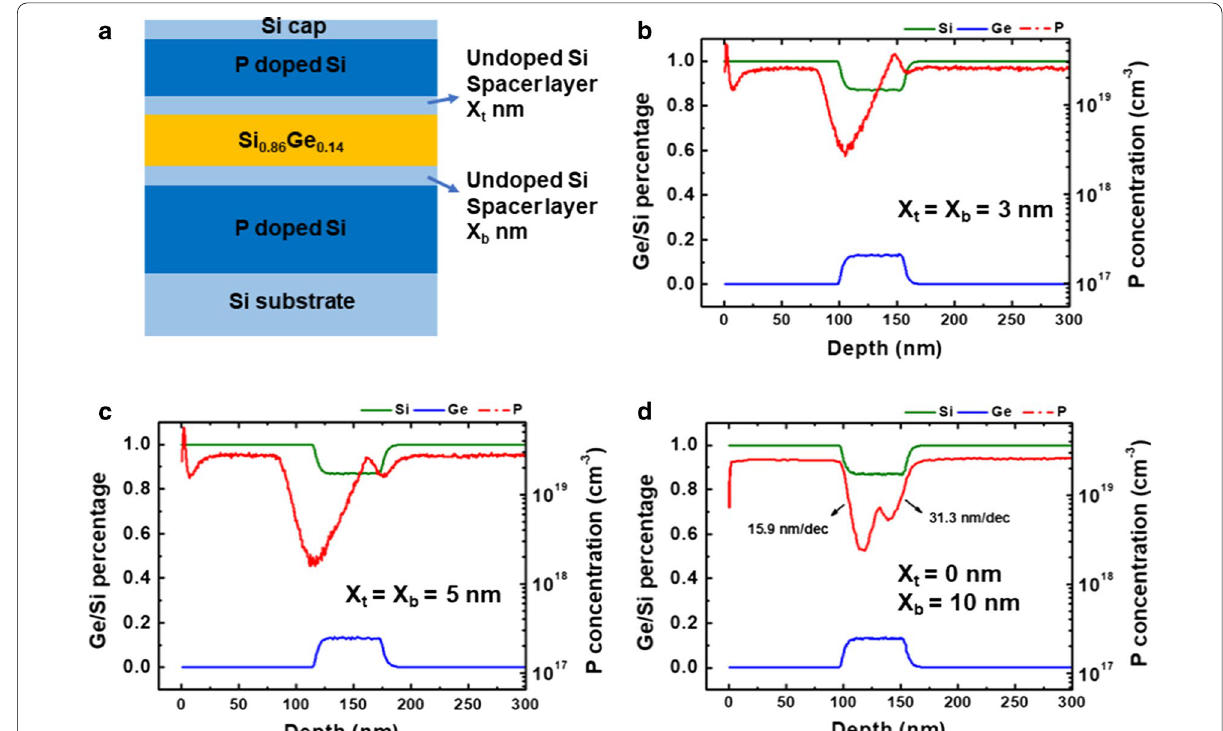
Fig. 2 a The schematic of experimental samples with different undoped spacer layers. And Ge, Si, and P profiles of P-doped Si/Si 0.86 Ge 0.14 /P-doped Si MLs with undoped Si spacer layers of b 3 nm, in both interfaces, c 5 nm, in both interfaces, d 10 nm, only at one interface with Si 0.86 Ge